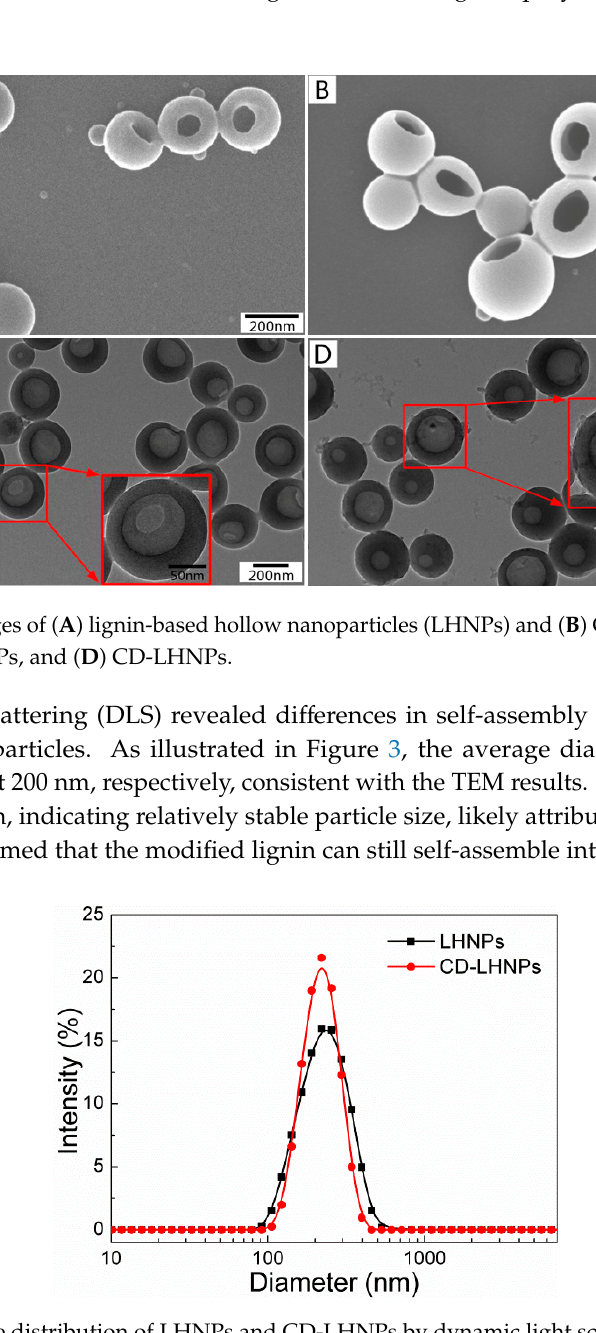
Figure 3. Size distribution of LHNPs and CD-LHNPs by dynamic light scattering (DLS).